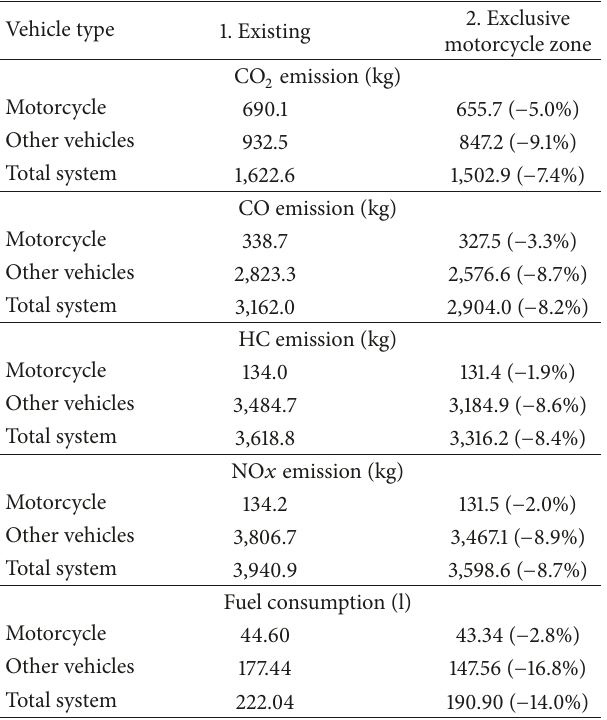
Table 7: Results of evaluation of emissions and fuel consumption. Vehicle